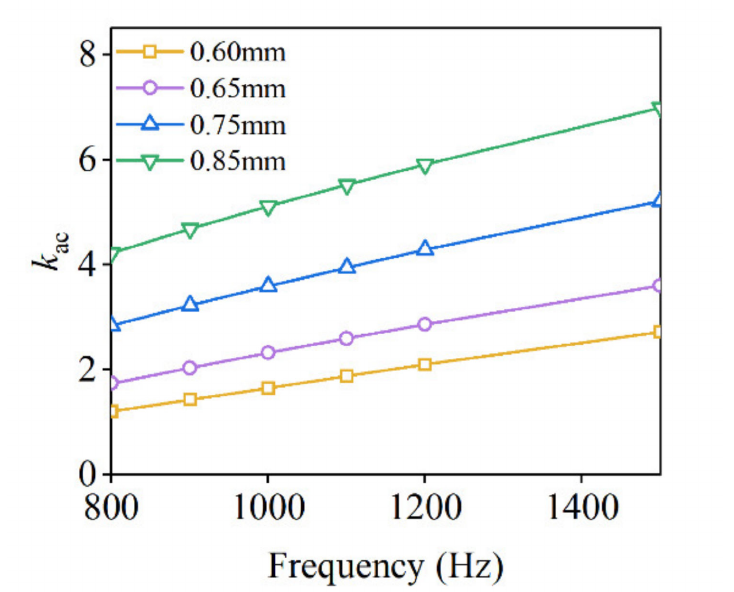
Figure 9. AC/DC copper loss ratio k ac with conductor diameter at different frequencies for Case A. Another case (Case B) is adopted to study the influence of conductor diameter on the AC copper losses in this paper. Maintaining the same copper fill rate, the influencing law of the conductor diameter on the AC copper losses is summarized. The conductor strand number must be reduced with the conductor diameter increasing to keep the same slot full rate. The windings arrangement parameters are shown in Table 2. Similarly, the influence of conductor diameter on current density distribution, copper loss and AC/DC loss ratio kac is analyzed in Figures 10–13.